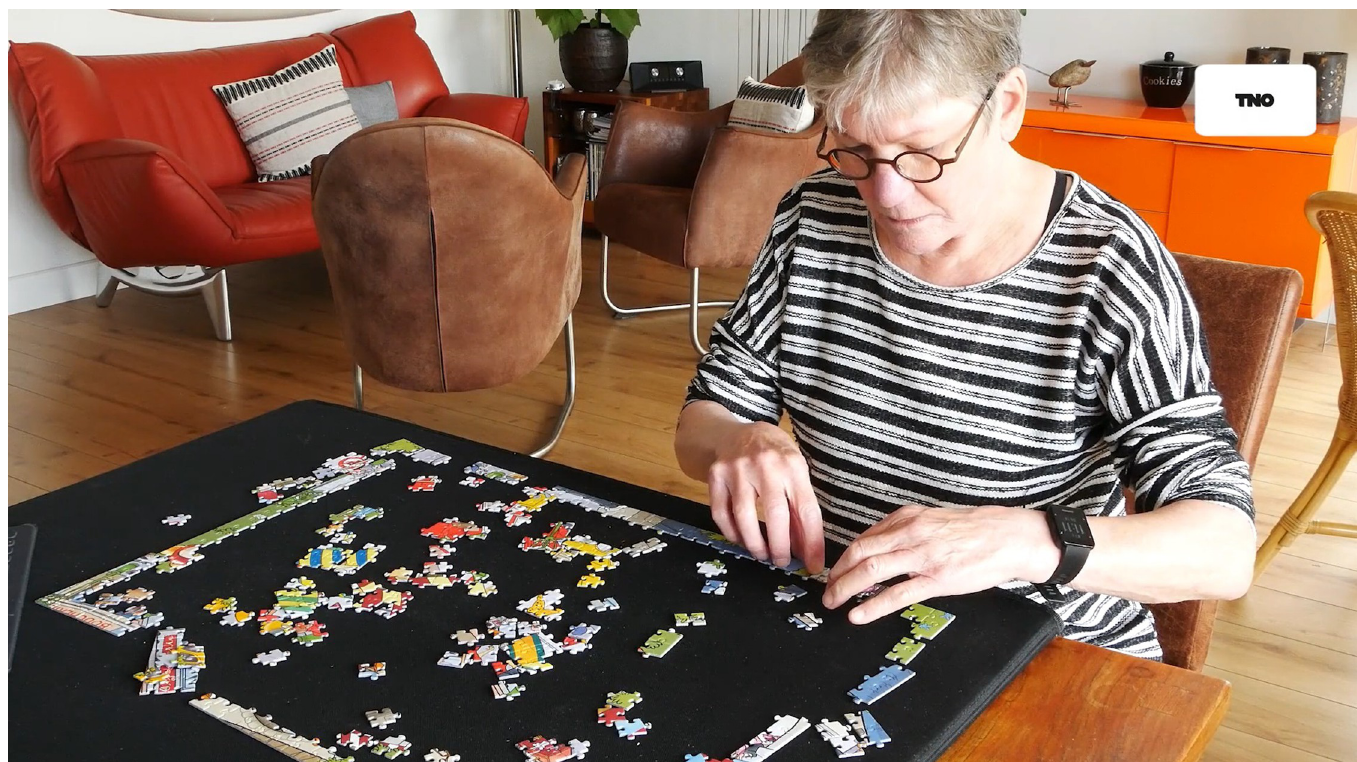
Fig 2. Screenshot short film. Showing Anne-Marie, a 70-year old woman during activities in times of corona.